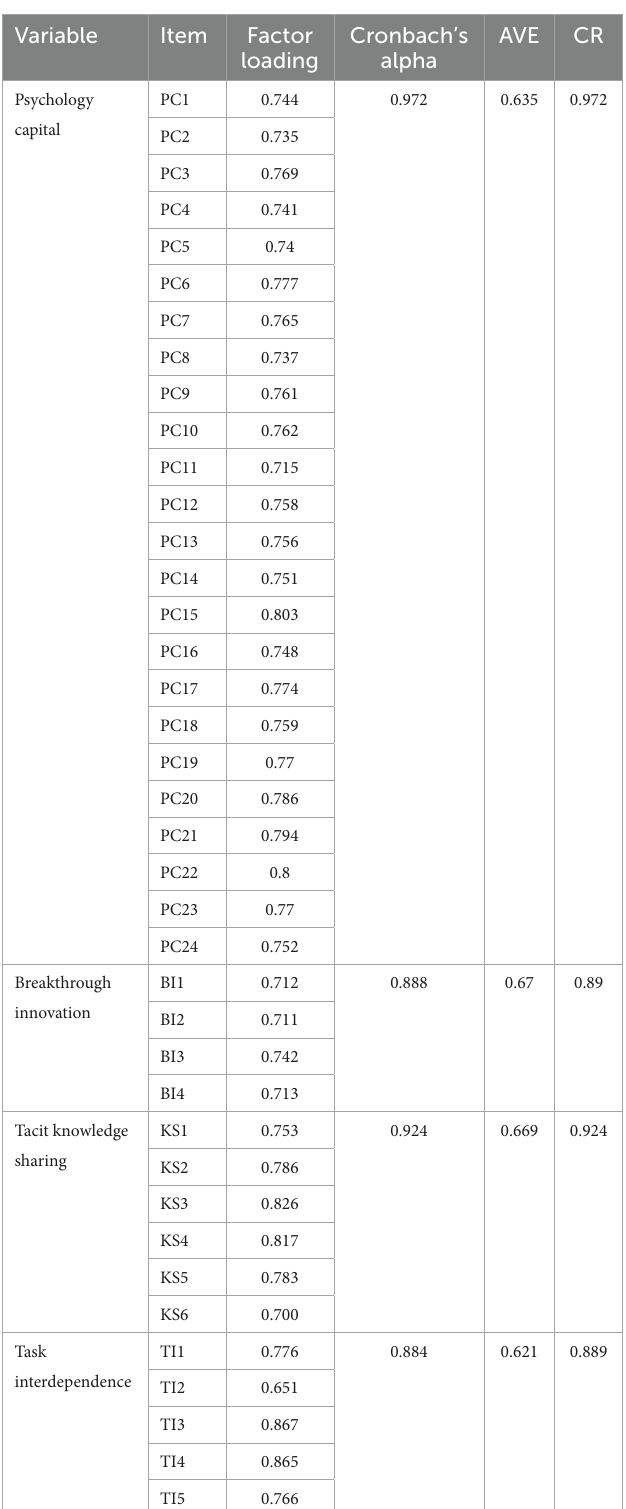
TABLE 3 Validity test